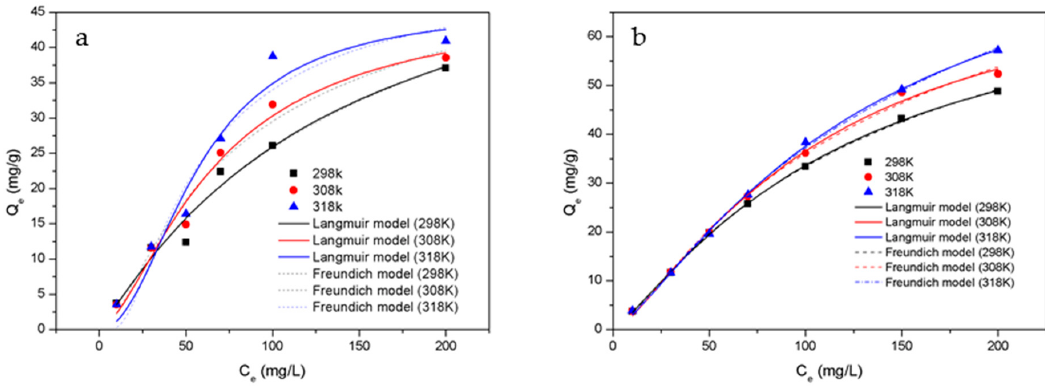
Figure 8. Adsorption isotherm fitting diagram of Cr(VI) onto samples: ( a ) HTC and ( b ) HTC-NH 2 .